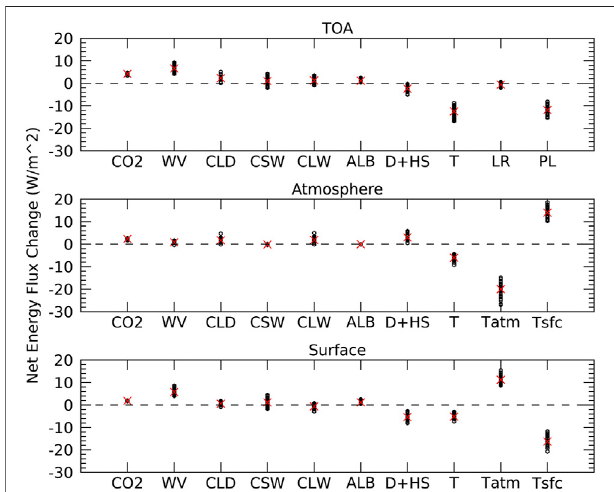
FIGURE 1 | The global-mean net energy fl ux changes (W*m − 2 ) between the CMIP5 RCP8.5 and historical simulations at the TOA, atmosphere, and surface due to changes in CO 2 , water vapor (WV), clouds (CLD), the shortwave (CSW) and longwave (CLW) cloud components, surface albedo (ALB), dynamics plus heat storage (D + HS), and temperature (T). Temperature feedback (T) is further divided into lapse-rate (LR) and Planck (PL) feedbacks at the TOA, and atmospheric (Tatm) and surface (Tsfc) temperature feedbacks in the atmosphere and surface. Note that the sum of the surface and atmosphere contributions equals their respective TOA contributions, except for the last two terms on the right. Black circles indicate individual CMIP5 model results, while red crosses show the CMIP5 ensemble